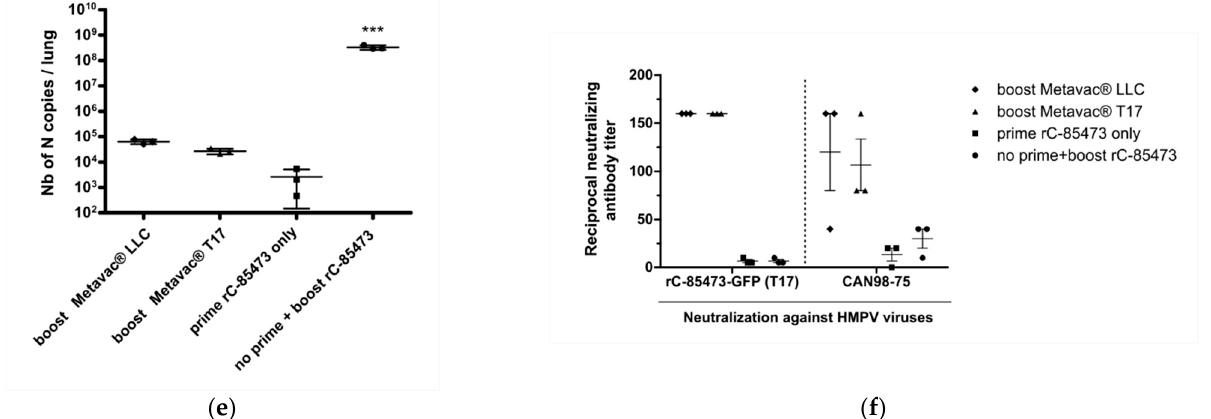
Figure 6. Evaluation of pulmonary replication and immunogenicity in BALB/c mice after prime or boost infection with T17-produced HMPV LAV candidate. ( a – c ) BALB/c mice intranasally infected with 1 × 10 6 TCID 50 of Metavac ® viruses and monitored for 14 days after infection ( n = 20), as represented in schematic timeline ( a ), with ( b) weight loss ( n = 16) and ( c ) pulmonary viral titers quantified by RT-qPCR from lungs harvested at 5 dpi ( n = 4); ( d , f ) BALB/c mice prime-infected with 5 × 10 5 TCID 50 of the rC-85473-GFP virus and boost-infected after 30 dpi with 5 × 10 5 TCID 50 of the Metavac ® LLC or T17 viruses via the intranasal route, and monitoring was performed as presented in ( d ); ( e ) pulmonary viral titers quantified by RT-qPCR from lungs harvested at 5 days post-boost ( n = 3); ( f ) induction of neutralizing antibodies by Metavac ® viruses in mice 21 days post-boost. Three pools of sera from two mice were tested for neutralization against two WT HMPV strains, the homologous rC-85473-GFP virus produced in DuckCelt ® -T17 cells and the heterologous CAN98-75 virus, resulting in three biological replicates per group. One day before prime infection, the naïve status of mice was confirmed by a microneutralization assay from a pool of sera. *** p < 0.001 when comparing each group to the no-boost condition using one-way ANOVA with Dunnett’s post-test. i.n.:,intranasal.